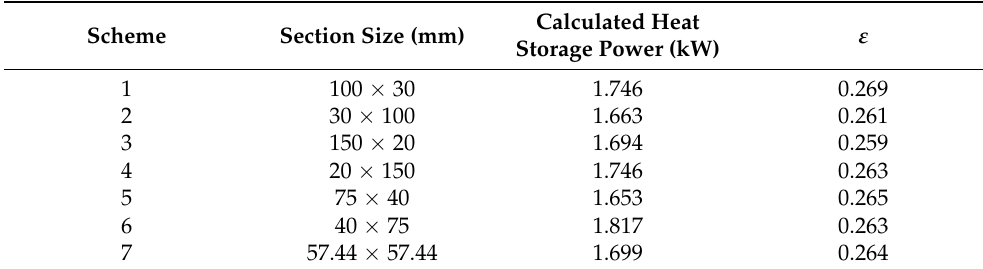
Table 9. Temperature increase slope of unit load of reservoir corresponding to geometric sizes of different phase change heat storage modules.